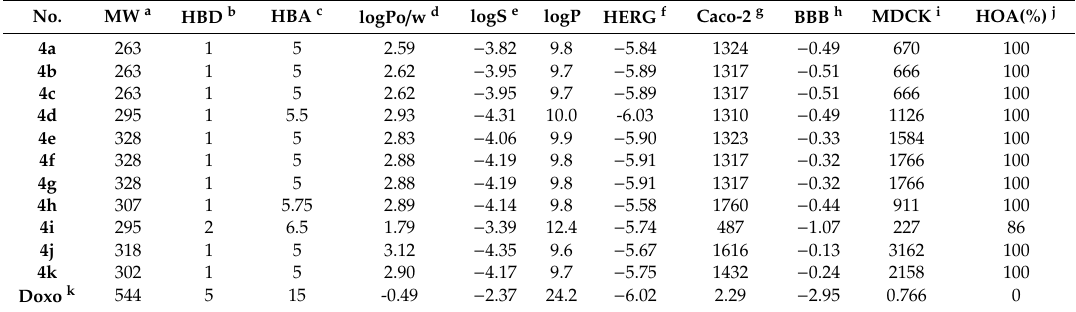
Table 3. Analysis of drug likeness and pharmacokinetic properties by QikProp for compounds 4a–k